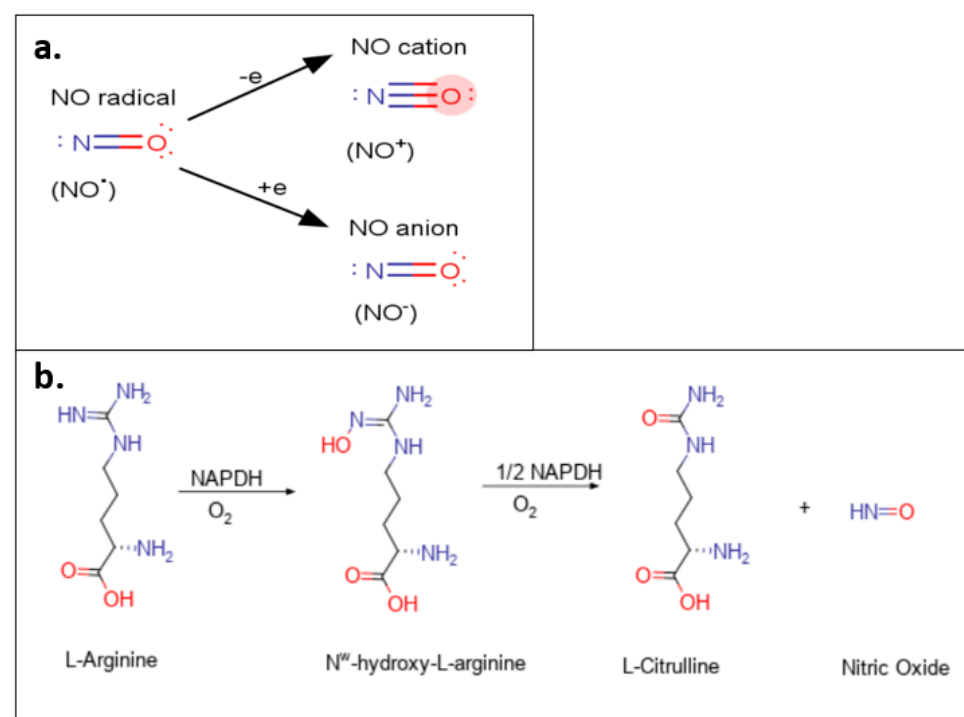
Figure 1. ( a ) NO redox species. NO exists as three different redox species: the NO radical (NO • ); the nitrosonium cation (NO + ); and the NO anion (NO − ), which reversibly transitions between species via the addition or loss of an electron. ( b ) NO production via L -arginine. NO production occurs endogenously by the conversion of L -arginine to L -citrulline via the intermediate N ω -hydroxy- L -arginine. NADPH serves as an electron donor for both reactions.